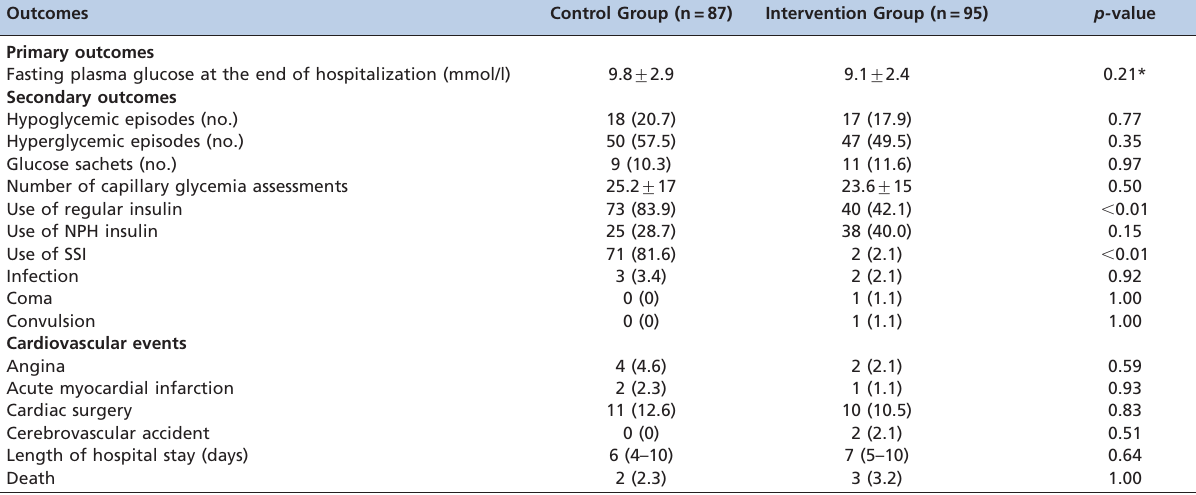
Table 2 - Primary and secondary